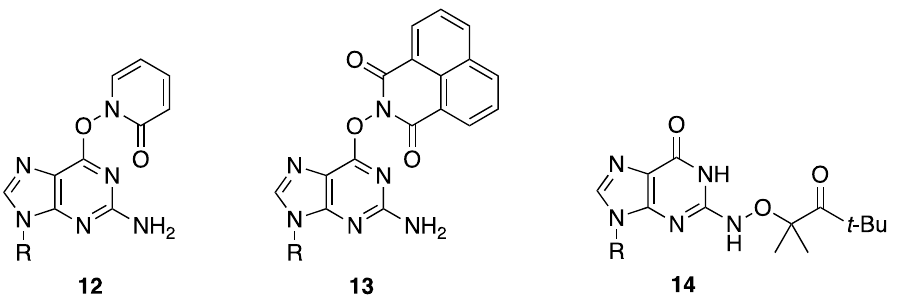
Figure 7. Photochemical precursors 12 and 13 for the formation of G(N1-H) • , and 14 for the formation of G(N2-H) • .